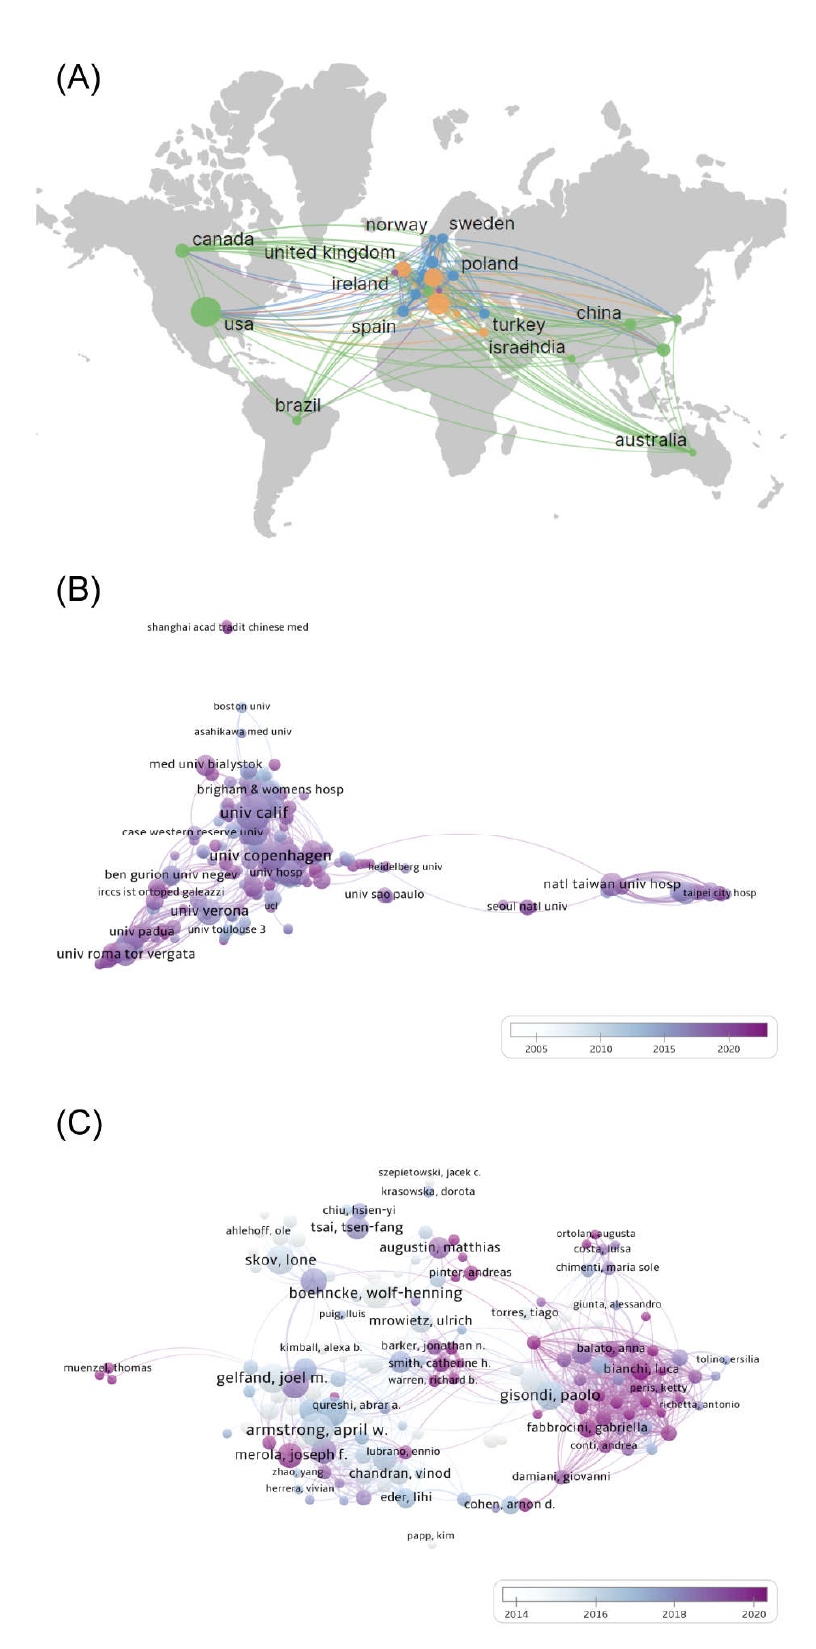
Figure 3. Collaboration network in psoriasis co-morbidities. ( A ) Country and region ( B ) Institutional ( C ) Author collaboration network.